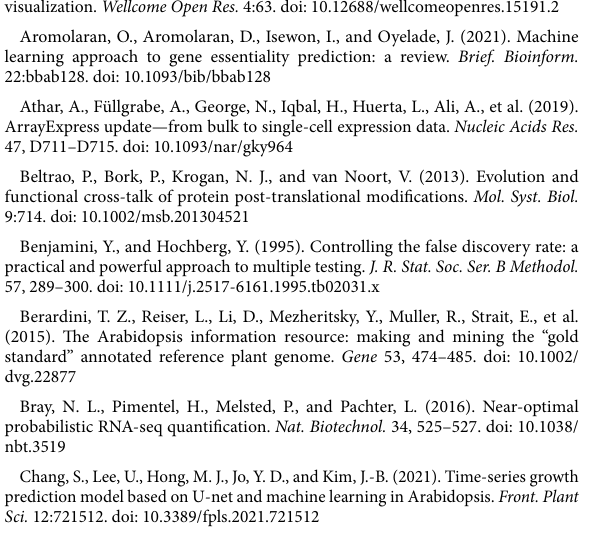
SUPPLEMENTARY TABLE S6 Frequency of individual HPs during HP optimisation across different score categories, excel sheet. SUPPLEMENTARY TABLE S7 Frequency of groups HPs during HP optimisation across different score categories, excel